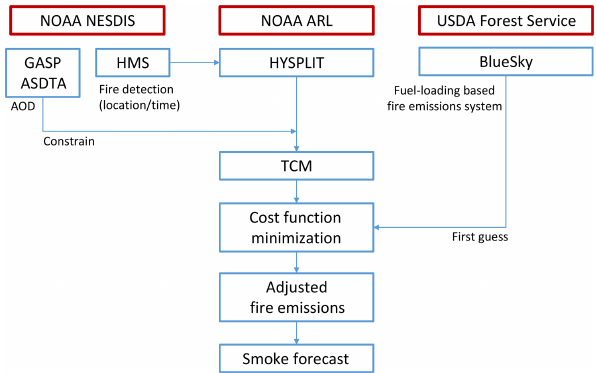
Figure 1. Schematic diagram of the HYSPLIT-based Fire Emission Inverse Modeling